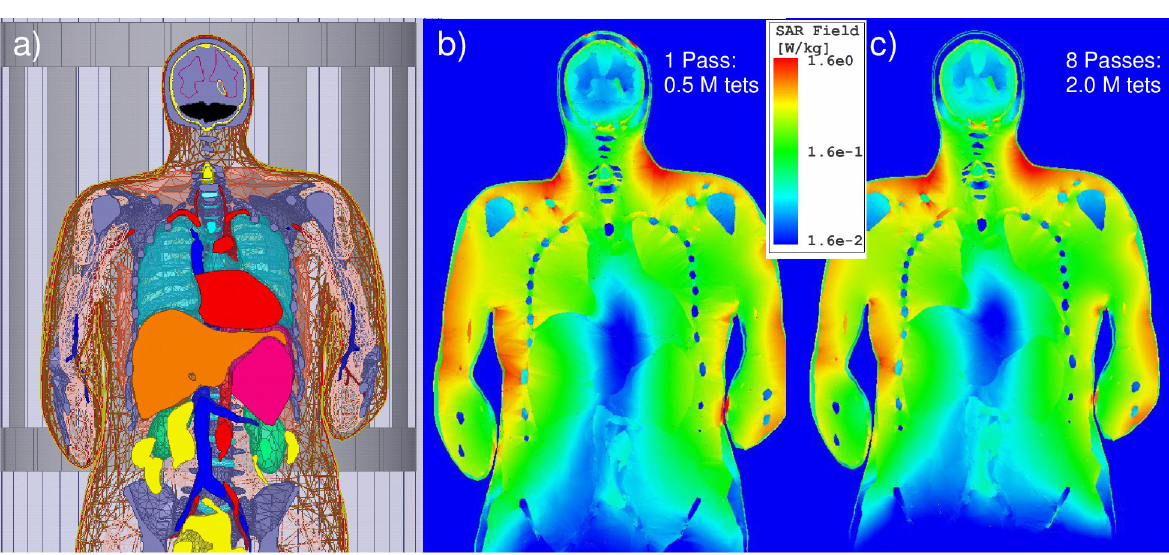
Fig 2. Local SAR distribution in the coronal plane for a high pass full-body RF coil operating at 64 MHz loaded with the VHP-Female v5.0 amplitude of 1 μ T at the coil center. a)–Positioning of model within the birdcage at shoulder/heart landmark. computational phantom given B þ 1 b)–Ansys HFSS (Electronics Desktop) solution with one adaptive pass. c)–Solution with eight adaptive passes.